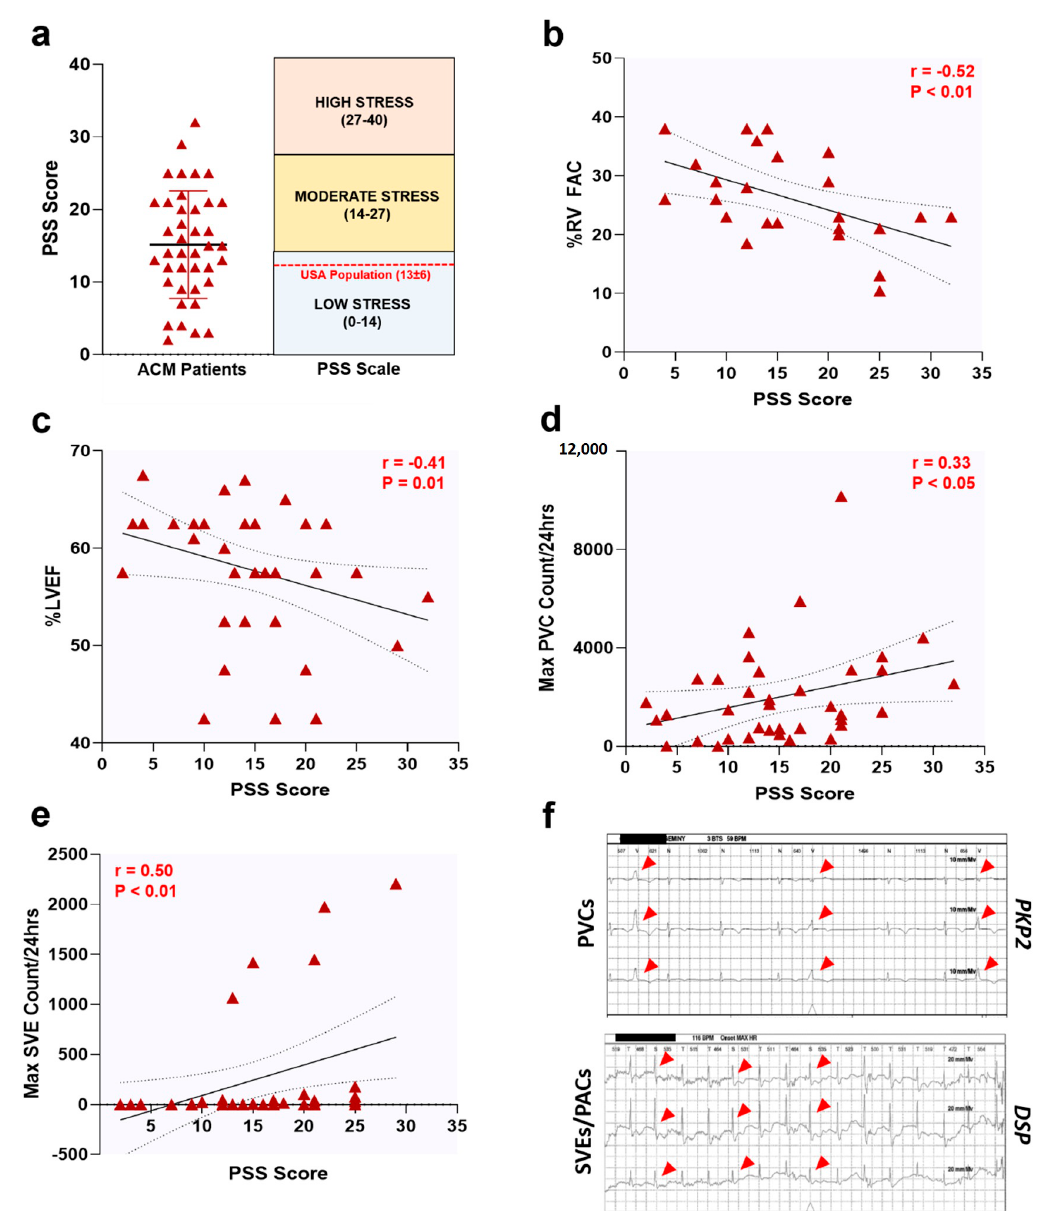
Figure 1. Perceived stress levels correlate with cardiac dysfunction in ACM patients. ( a ) PSS scores in n = 40 ACM patients. Data presented as Mean ± StDev. Upon further analysis, PSS scores correlated with ACM patient phenotypes; notably, ( b ) percent right ventricular fractional area change (%RV FAC), ( c ) percent left ventricular ejection fraction (%LVEF), ( d ) maximum premature ventricular contractions per 24 h (Max PVC Count / 24 h), and ( e ) maximum supraventricular ectopics per 24 h (Max SVE Count / 24 h). Data displayed in scatterplots; thick black line shows the best linear fit through the data; dotted lines represent two-tailed 95% confidence interval; text inset reports Spearman’s Rho value and associated p -value. For ( a – e ), each maroon triangle is an individual data point from a single patient. ( f ) Representative Holter strips showing PVCs (top panel) and SVEs (lower panel) from ACM patients harboring a Plakophilin-2 ( PKP2 ) and Desmoplakin ( DSP ) pathogenic variant, respectively. Red arrowheads, PVCs and SVEs.